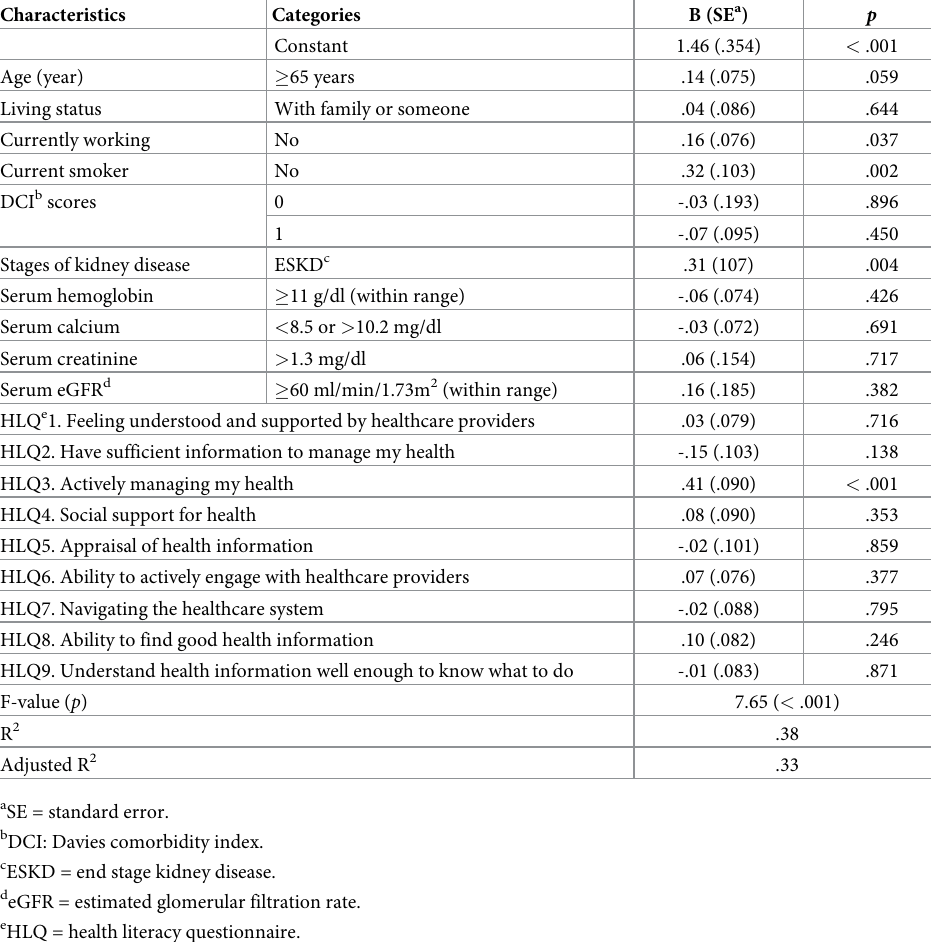
Table 5. Factors associated with participants’ self-care behaviors (N =